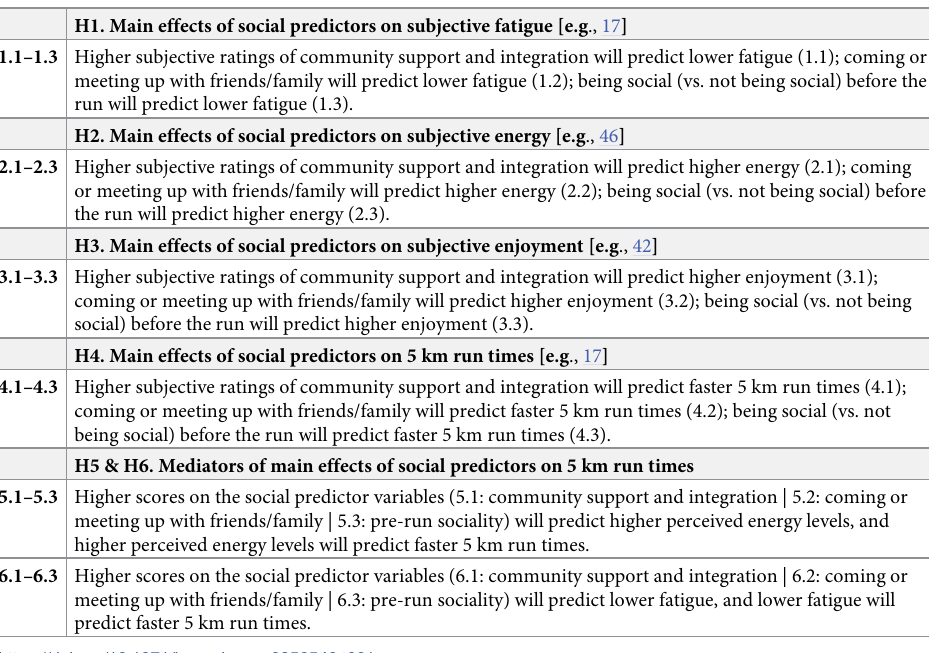
Table 1. Research